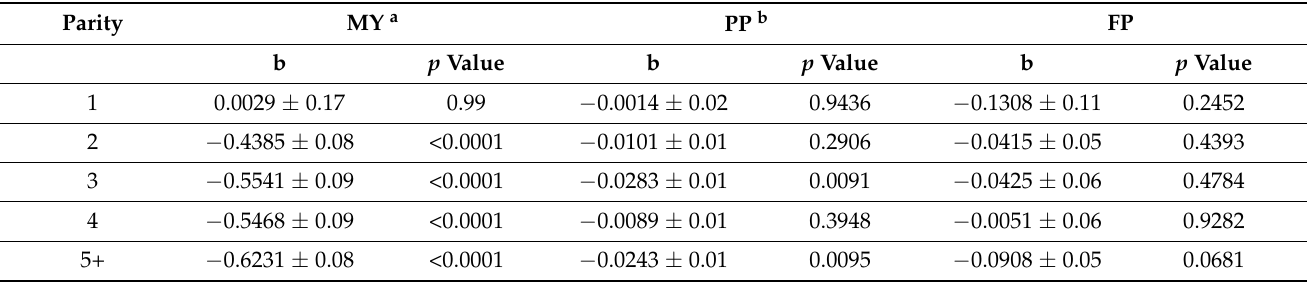
Table 3. Estimated linear regression coefficients of EC nested within parity for daily milk yield (MY, protein (PP) and fat percentage (FP) in Italian Mediterranean